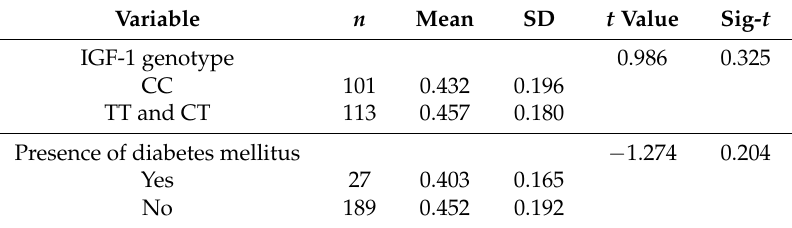
Table 3. Independent-sample t test between IGF-1 genotypes, diabetes and rate of bone resorption (CTX1).